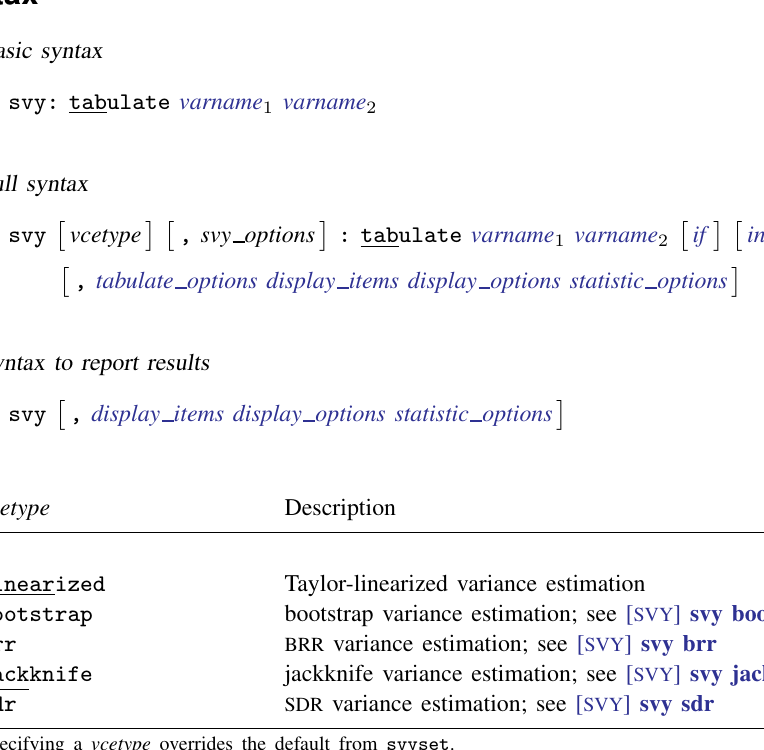
152 svy: tabulate twoway — Two-way tables for survey data